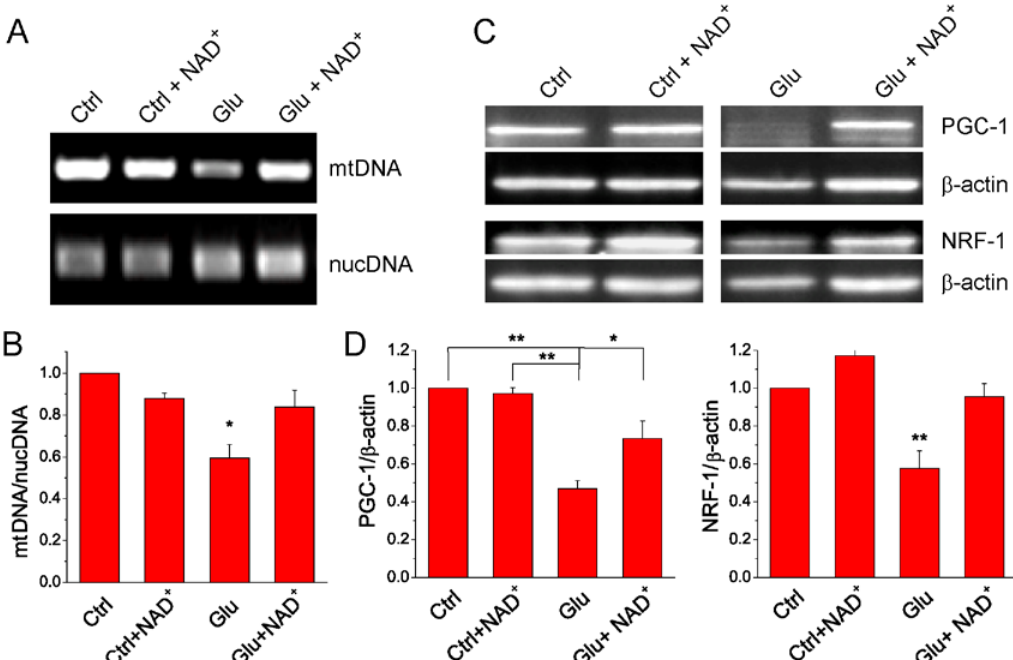
Figure 5. The effect of NAD + on neuronal mitochondrial biogenesis after glutamate stimulation. ( A ) Agarose gel image of mtDNA and nucDNA. mtDNA and nucDNA were extracted from neurons cultured under different conditions and amplified by qPCR following. Neurons were treated with 30 μM glutamate together with 3 μM glycine for 24 h in the presence or absence of 15 mM NAD + ; ( B ) Quantification of mtDNA amount in each condition. The data was presented as the ratio of mtDNA/nucDNA and normalized to the control condition using nucDNA as internal control. Notice that NAD + prevented glutamate induced decrease of mtDNA content; ( C ) Western blot images for PGC-1 and NRF-1 in control and glutamate stimulated primary neuronal cultures in the presence and absence of 15 mM NAD + ; ( D ) Quantitative analysis of PGC-1 and NRF-1 expression levels. The data were presented as the ratio of the proteins to β-actin and normalized to the control condition. All data ( B , D ) are shown as mean ± SE from three to six independent